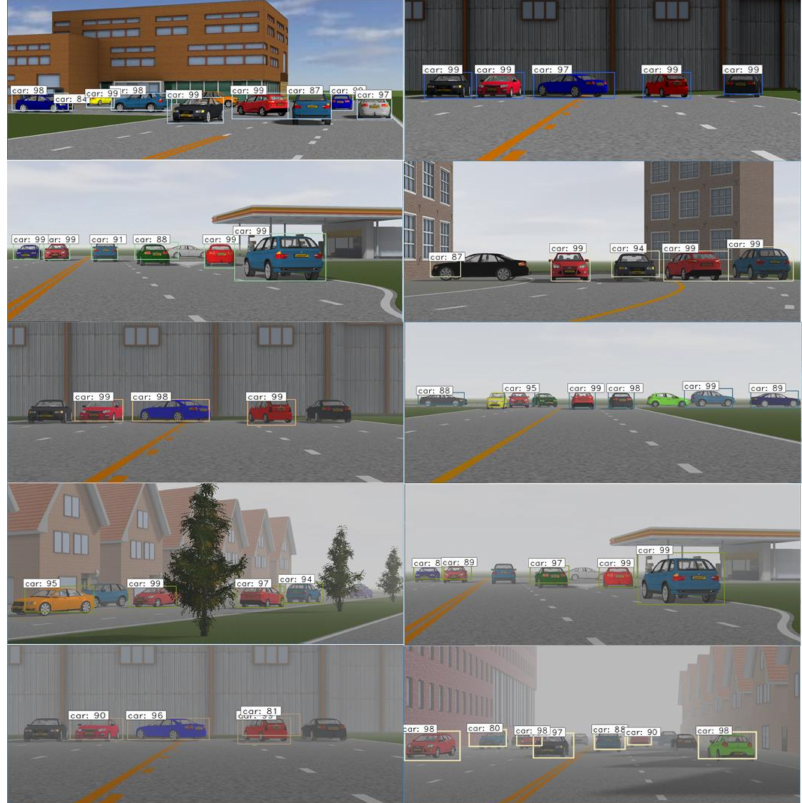
Figure 8. Display of the same scene in di ff erent visibility level, and the visible distance in picture with five layers from top to bottom are without fog, 800 m, 500 m, 300 m, and 200